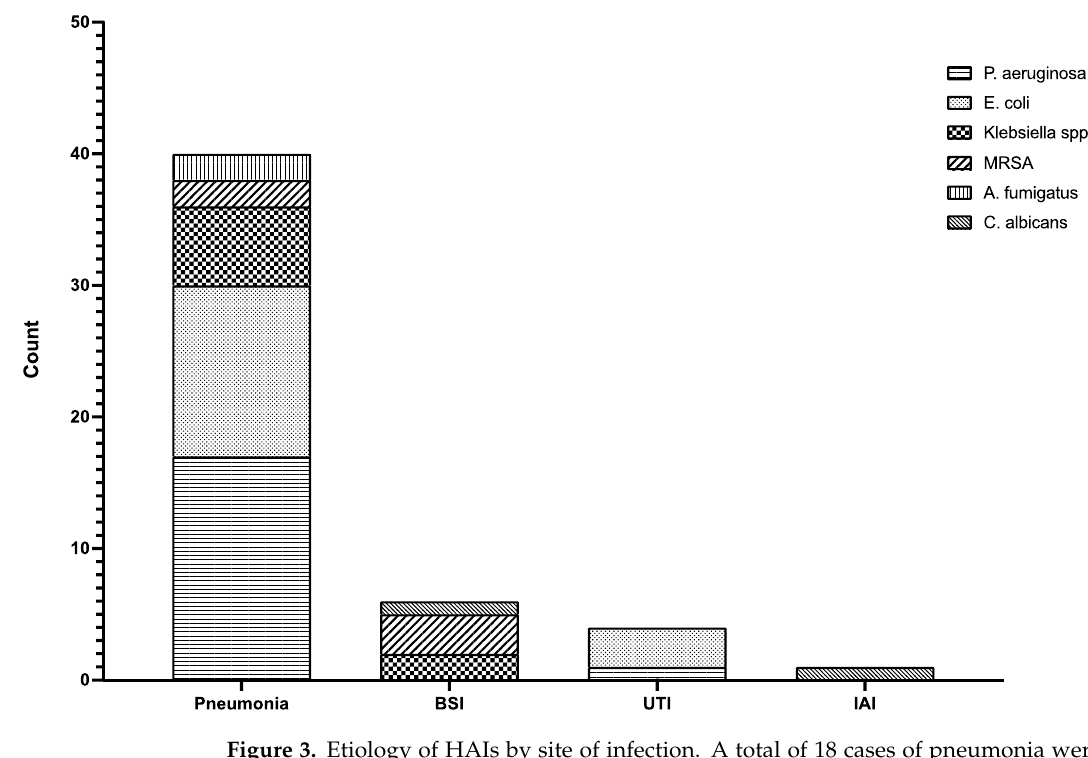
Table 2. Susceptibility to antibiotic classes for the micro-organisms classified as multidrug